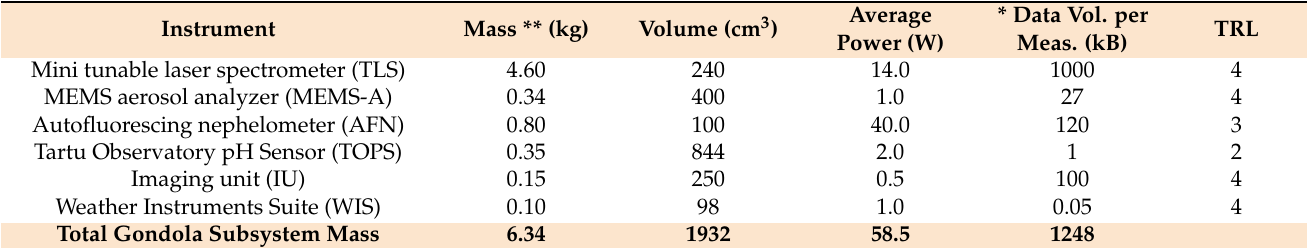
Table 4. Scientific instruments for the Venus Habitability